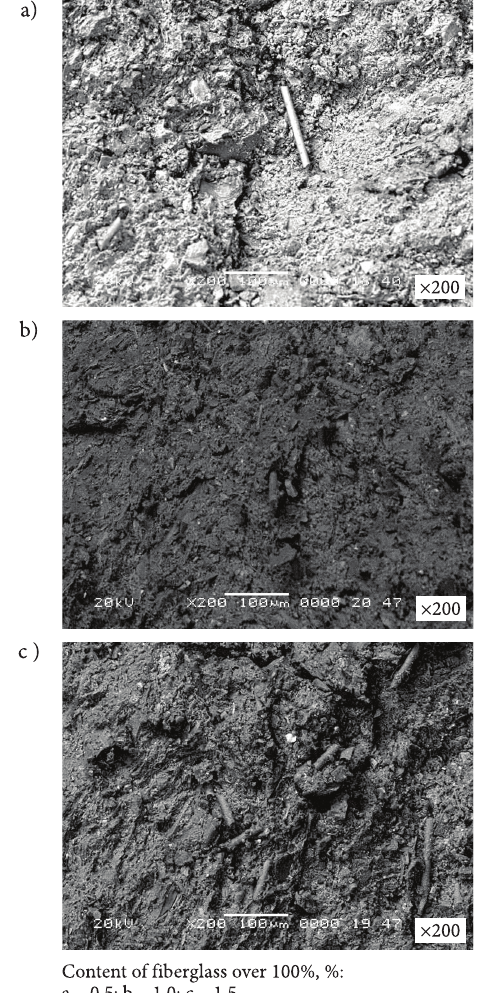
Fig. 5. Electron microscopic image of the surface of the chips of pressed samples of tiles